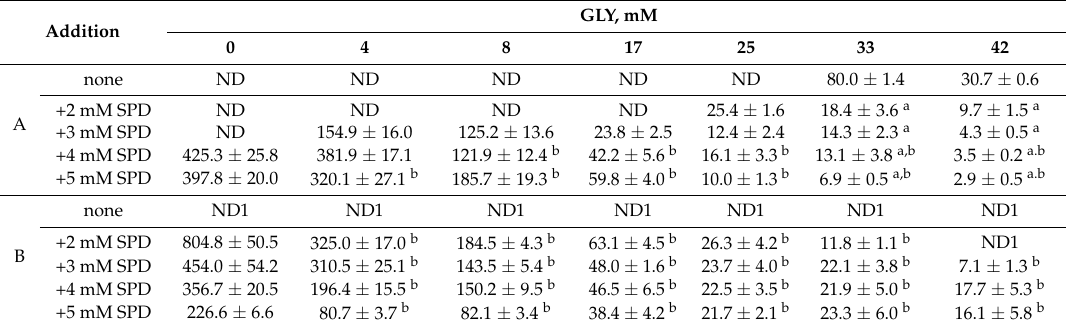
Table 3. Effect of different concentrations of SPD and GLY on the Young’s module (YM, MPa) of native (A) and heat-denatured (B) BV protein films obtained at pH 8.0 *.